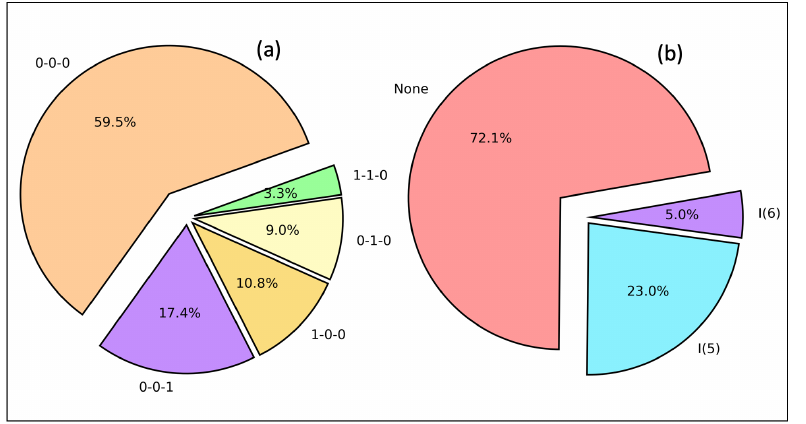
Figure 5. ( a ) Hydrogen bond networking and ( b ) intramolecular hydrogen bonds in database A (For networking, 0-0-0 defined in Equation (1), and for intramolecular HBs, I(5): five-membered ring and I(6): six-membered